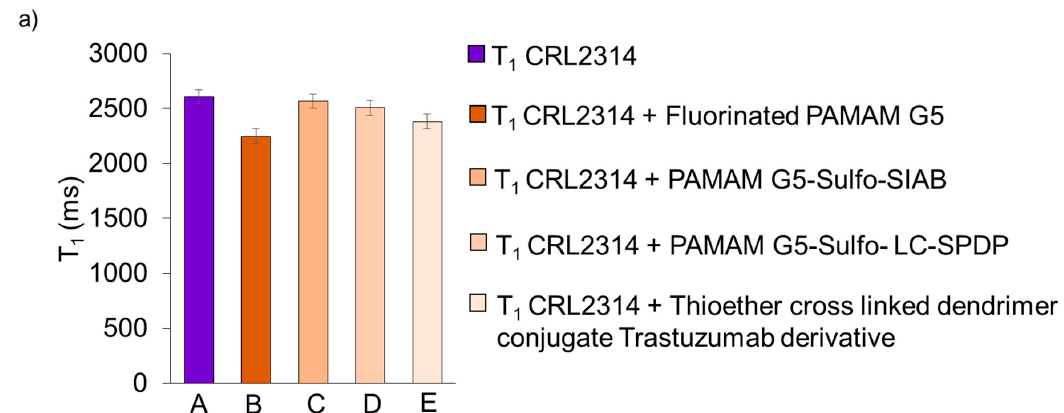
after 24 h (Figure 11).